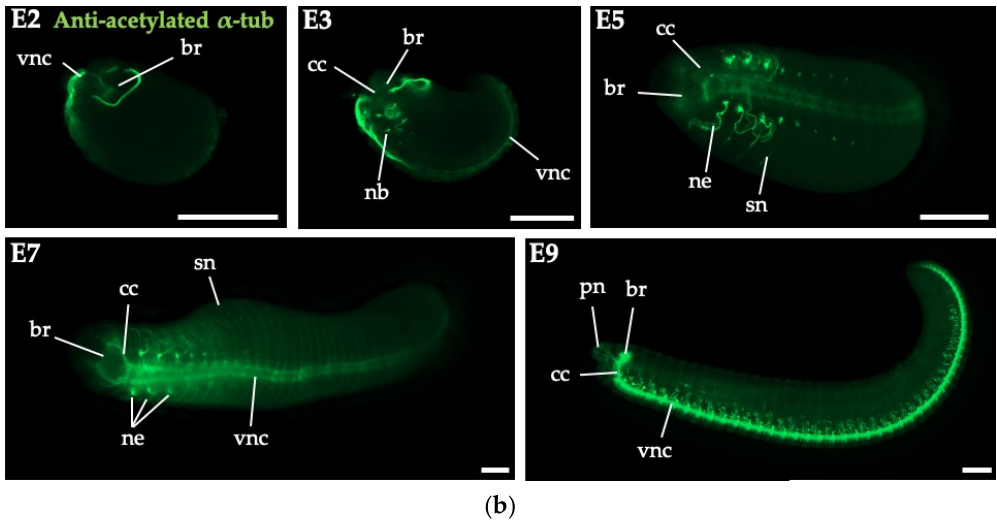
Figure 3. Myogenesis ( a ) and neurogenesis ( b ) of P. excavatus . ( a ) Myogenesis was visualized by phalloidin staining (red) in embryonic stages of P. excavatus . Arrows and arrowheads indicate longitudinal muscles (along the anterior–posterior axis) and circular muscles (perpendicular to the anterior–posterior axis), respectively. Scale bar, 200 µ m. ( b ) Nervous system development of P. excavatus visualized by immunohistochemistry using anti-acetylated α -tubulin (green). Abbreviations: br, brain; cc, circumesophageal connective; nb, nephroblast; ne, nephridium; pn, palp nerves; sn, segmental nerves; vnc, ventral nerve cord. Scale bar, 200 µ